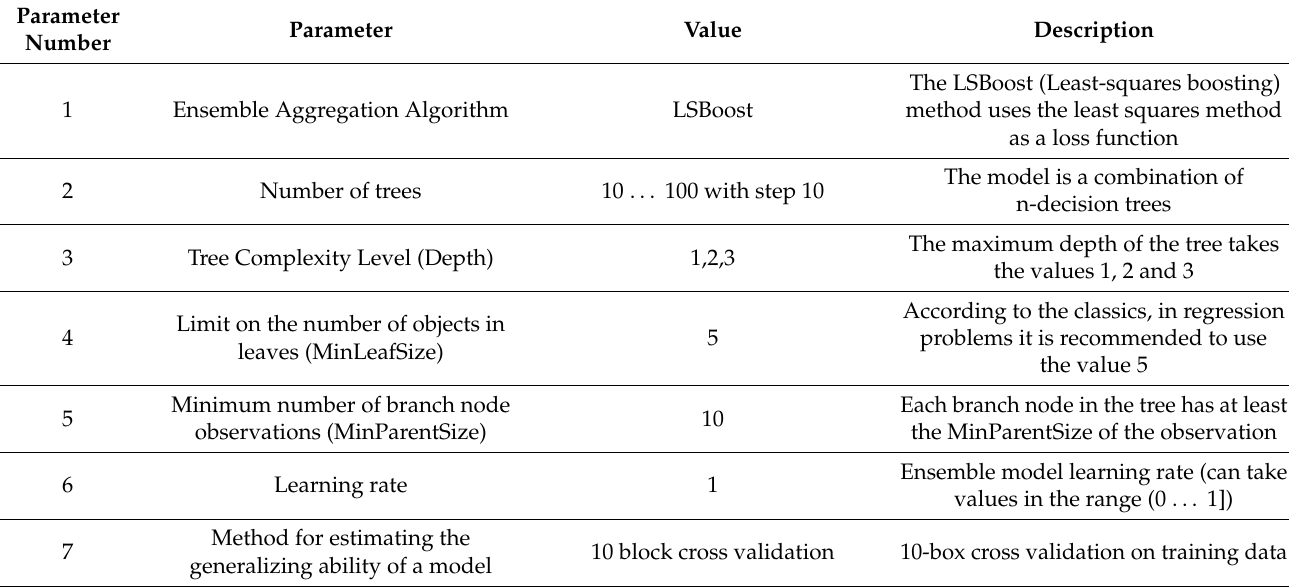
Table 4. Parameters of the ensemble model of regression